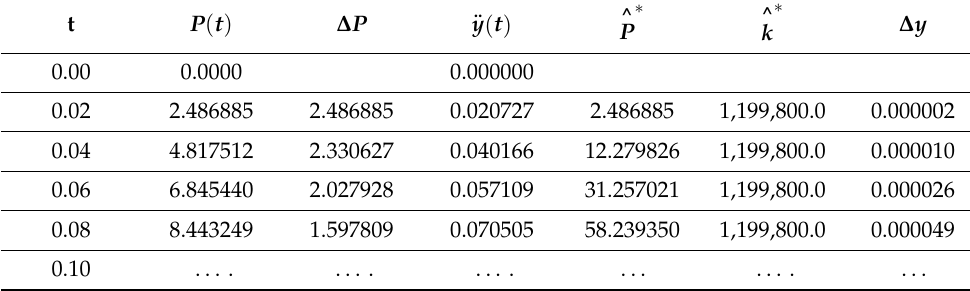
Table 2. Newmark Numerical Method for Linear Systems with Negative Stiffness.